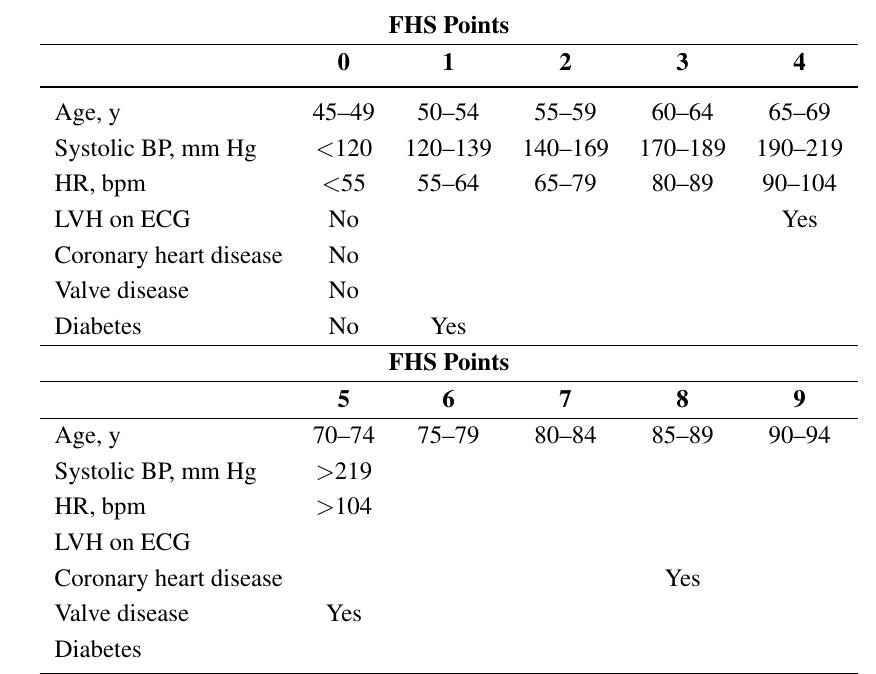
Table 2. Predictors for congestive heart failure within four years for men aged 45 to 94 years (with coronary disease, hypertension or valvular disease; the model is without vital capacity and chest X-ray results).